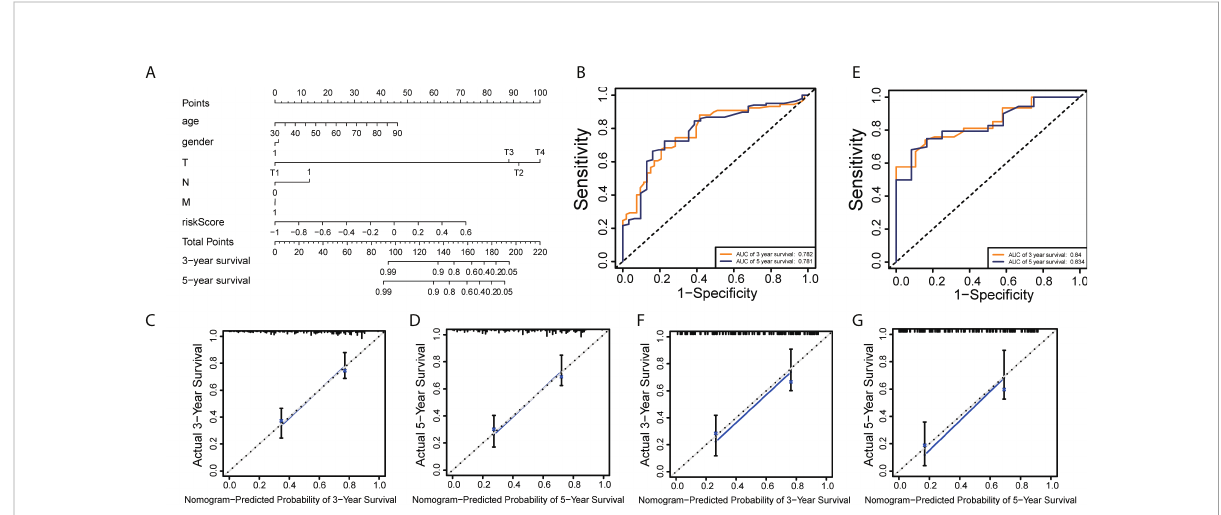
FIGURE 6 Establishment and interpretation of the nomogram for clinical variables and ERS-related lncRNAs. (A) Establishment of the nomogram. (B, E) ROC curve analyses of the nomogram in training and testing sets, respectively. (C, F) The nomogram ’ s 3-year OS calibration curve in training and testing groups, respectively. (D, G) The nomogram ’ s calibration curve for a 5-year OS in training and testing sets,